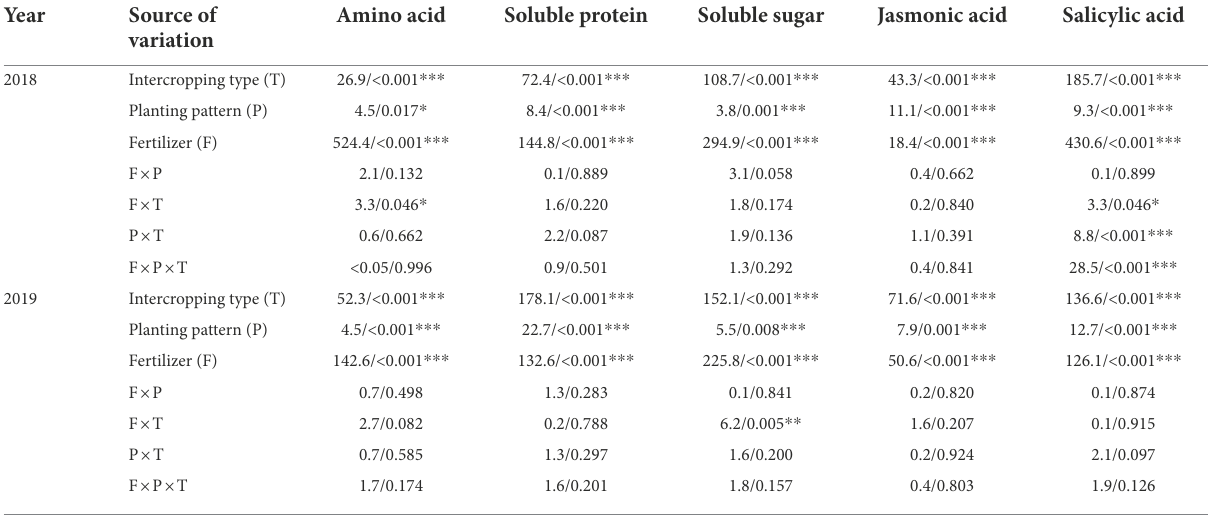
TABLE 3 Three-way ANOVAs about the effects of intercropping type (T; corn–soybean/peanut/millet intercropping), planting patterns (P; one corn monoculture and three planting patterns of corn intercropping with soybean/peanut/millet, respectively), fertilizer level (F; normal vs. reduced) and their bi-/tri-interactions on foliar contents of nutrients and plant hormones in 2018 and 2019 ( F / p value).